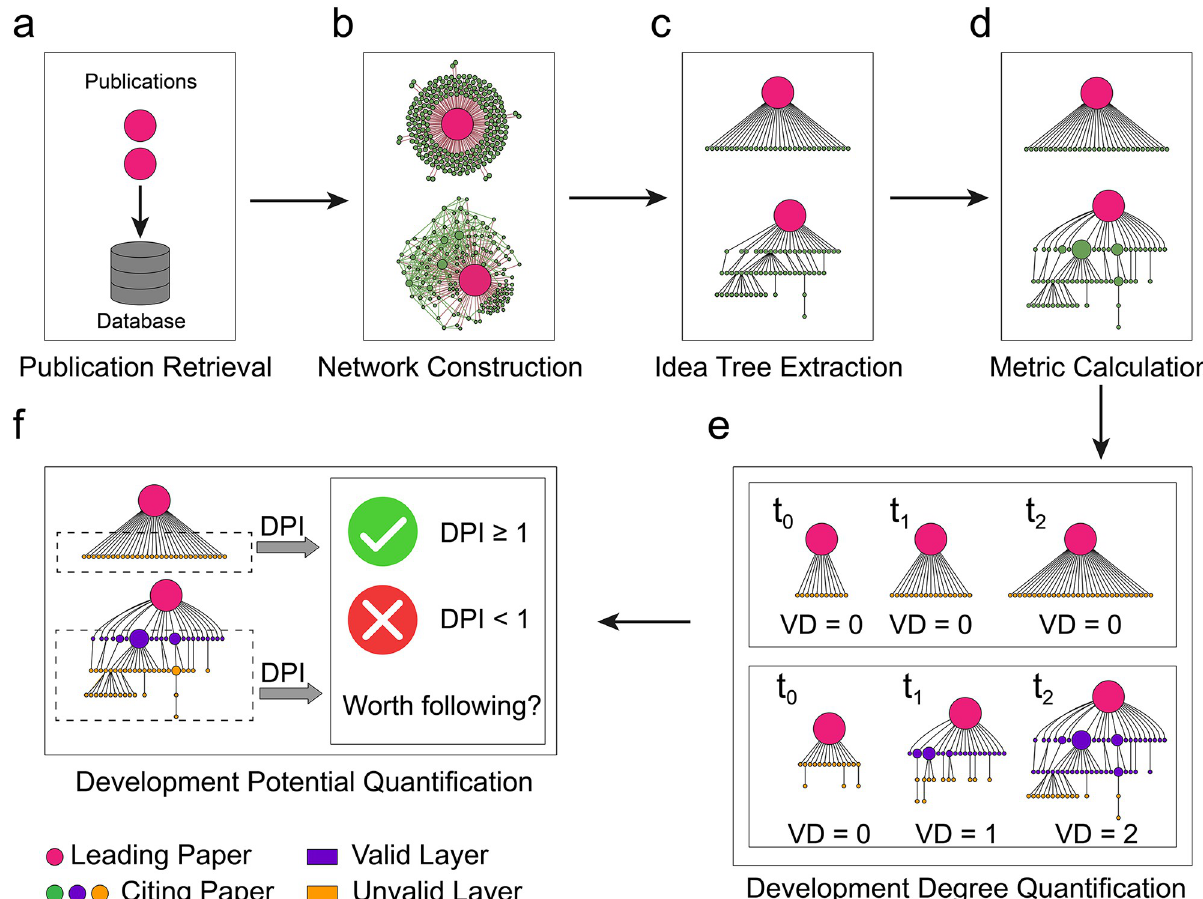
Fig 1. The framework of scientific X-ray. We illustrate the pipeline utilizing two publications with different citation structures. (a) Retrieve the citing papers of the target publication, all links among the target publication and citing articles and all links among citing papers in the database. (b) Construct the citation network of the target publication based on the retrieval results. (c) Extract the idea tree from the citation network to reveal the flow of the target publication’s idea. (d) Utilize Knowledge Entropy (KE) to quantify the knowledge quality of nodes in the idea tree to highlight the powerful inheritor of the target idea. (e) Reproduce the evolution of the idea tree and quantify the degree of development of the target publication’s idea utilizing the Valid Depth (VD). (f) Utilize the Development Potential Index (DPI) to quantify the potential of the target publication and assess whether it is worth continuing to